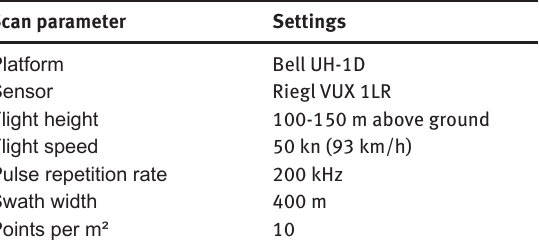
Table 1: Scan parameters and their settings used during the ALS data